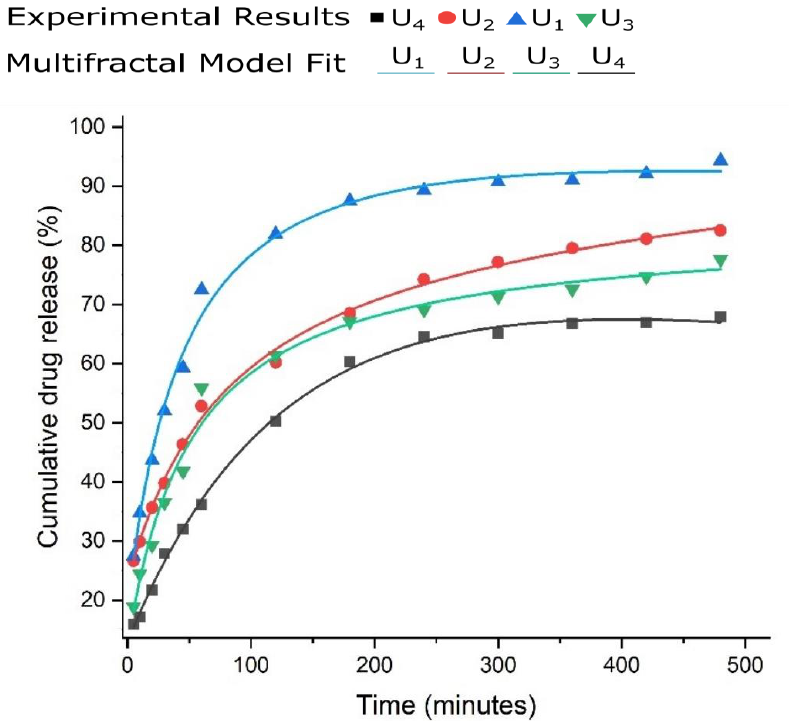
Figure 5. 5-fluorouracil release of experimental presentation [17]; the formulations are accommodated in multifractal theoretical replica (solid-colored lines).